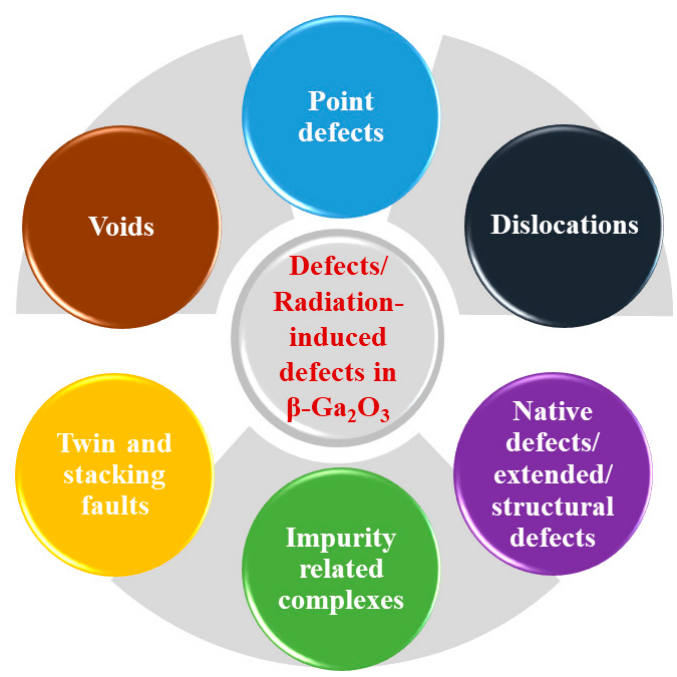
Figure 2. Summary of various intrinsic defects and/or radiation-induced